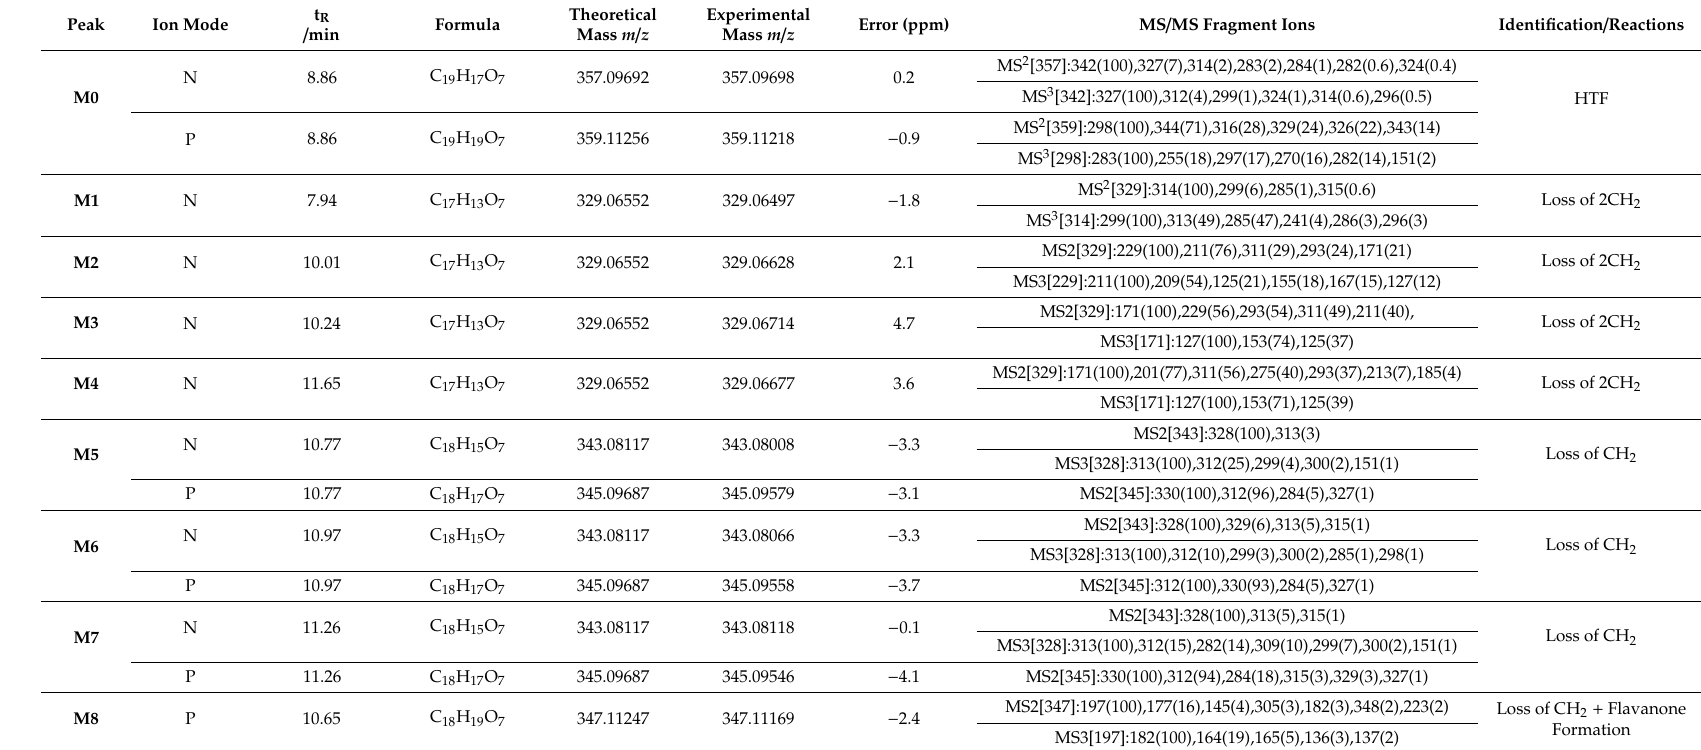
Table 2. Identification of HTF metabolites in rat urine and